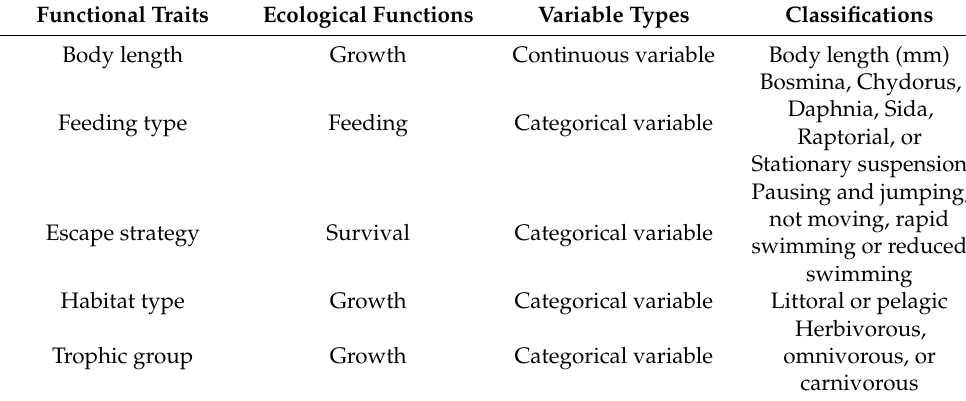
Bosmina, Chydorus, Daphnia, Sida, Raptorial, or Stationary suspension Pausing and jumping, not moving, rapid swimming or reduced swimming Herbivorous, omnivorous, or